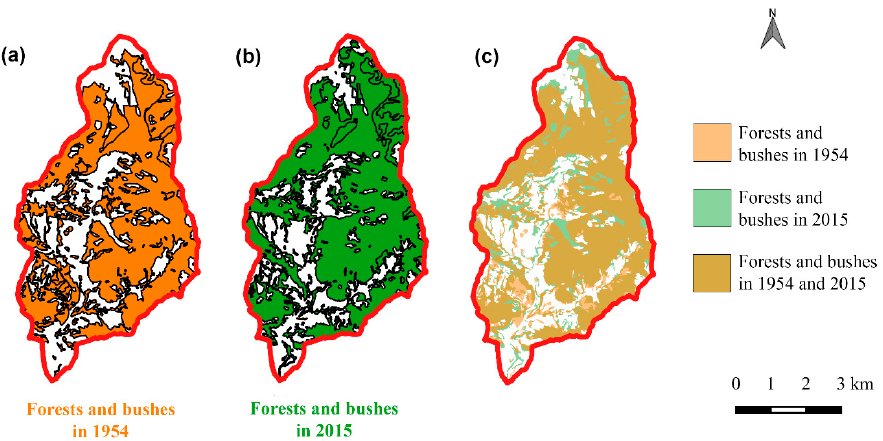
Figure 8. Forests and bushes in the Guerna catchment: ( a ) in 1954, ( b ) in 2015, and ( c ) overlapping them.